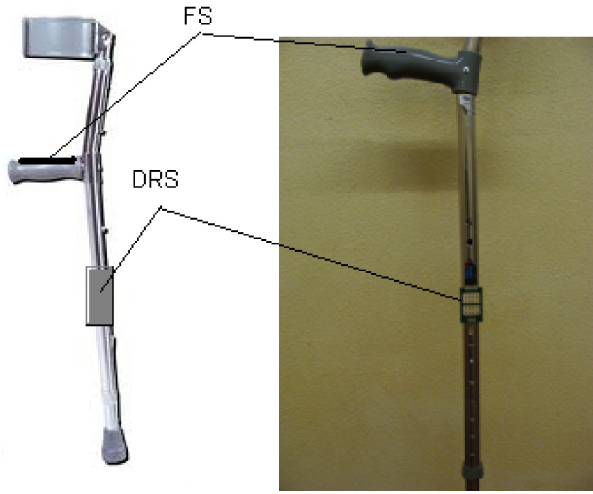
Figure 5. Smart crutches architecture and prototype (DRS = Doppler radar sensor; FS = piezoresistive force